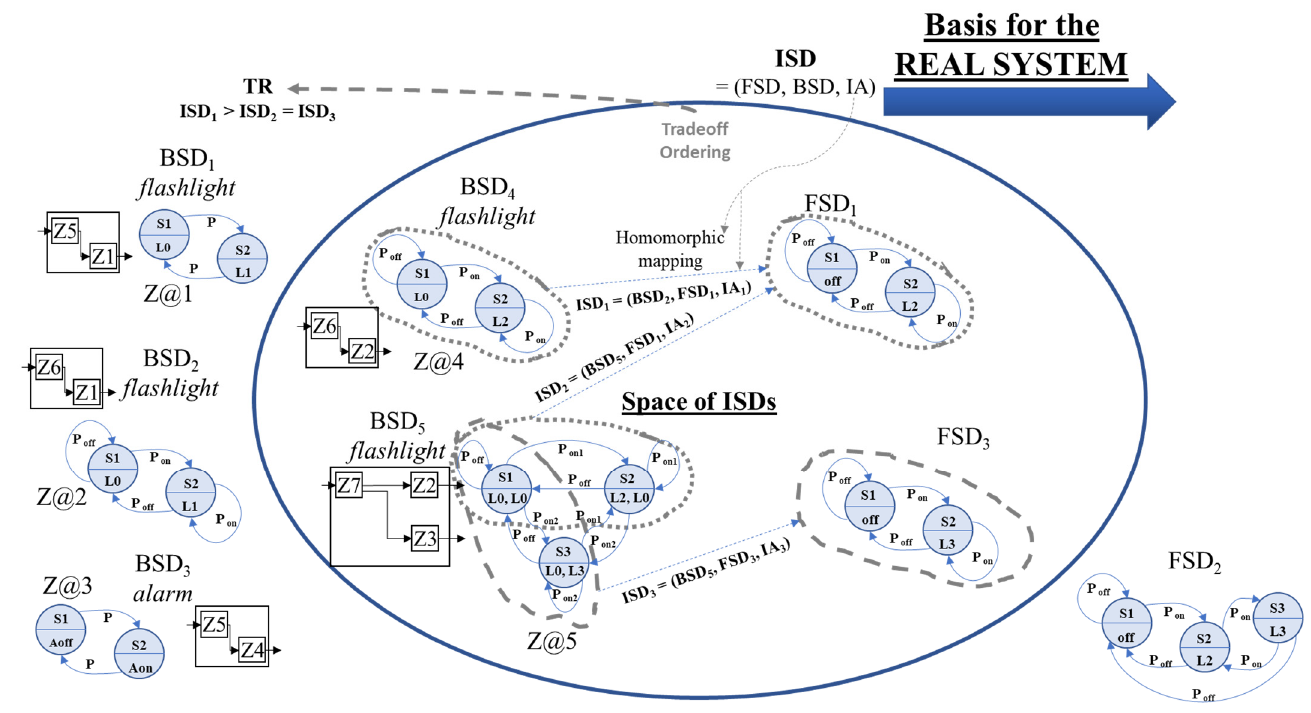
Figure 10. Practical illustration of the Implementability perspective to showcase the process for engineering a flashlight; including the homomorphic relationship between the functional and buildable designs that meet both the required input/output, meet the required technology availability, and are ordered according to the preferred tradeoff. The diagram does not represent a single model of the system, but a solution space. Each pair state machine/block diagram represents one possible solution inside the implementability space. This figure is used only to support our narrative to explain Wymore’s T3SD. The figure is NOT a formal visualization of any model.